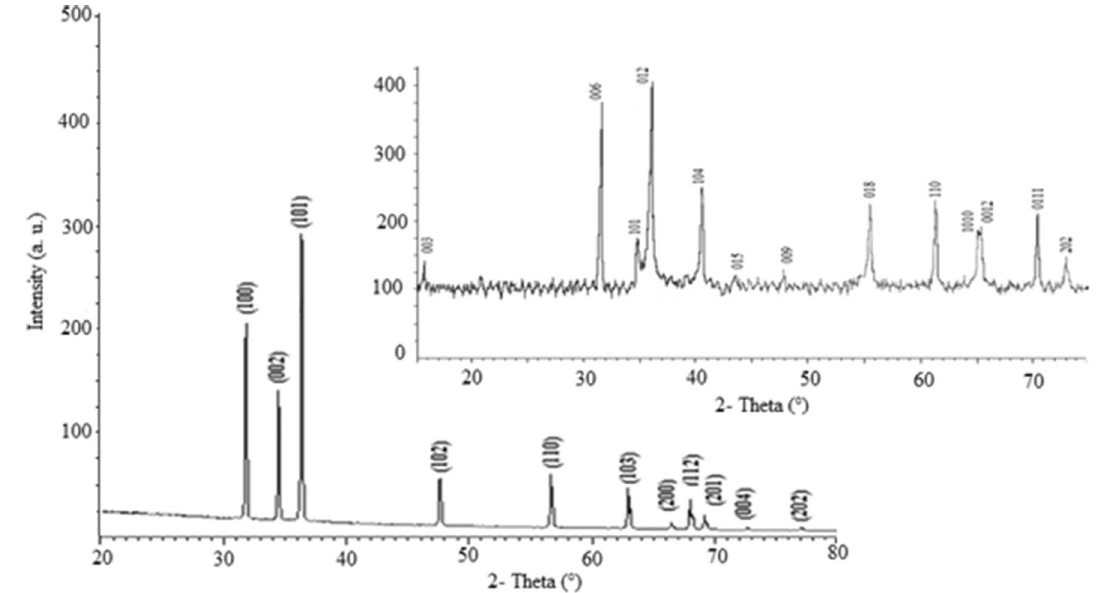
Fig. 1 The XRD pattern of ZnO prepared by chemical route. Inset: the pattern of the delafossite CuFeO